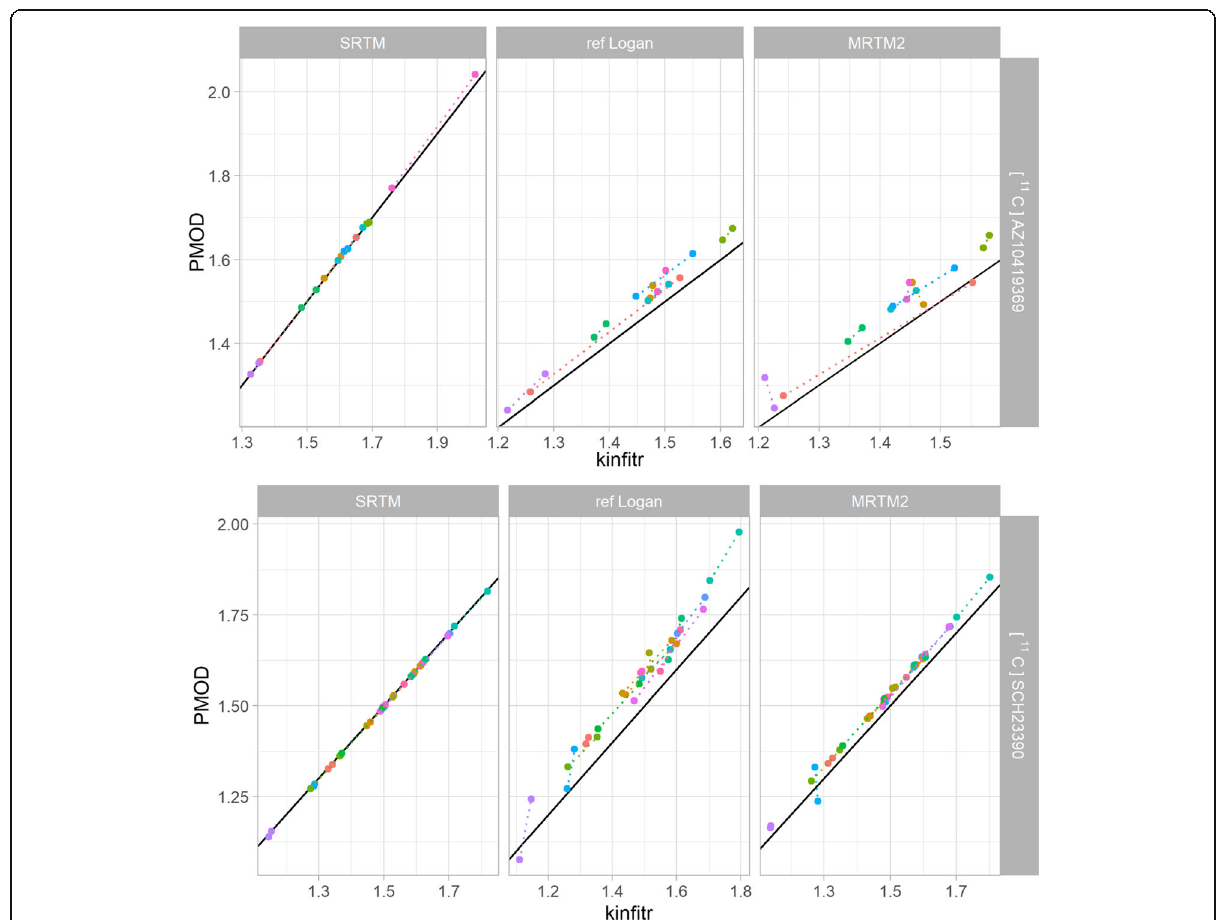
Fig. 1 Comparison of BP ND values calculated by kinfitr and PMOD. The relationship between binding estimates calculated by either kinfitr or PMOD. The results for the radioligand [ 11 C]AZ10419369 are derived from the occipital cortex ROI, and for [ 11 C]SCH23390, the striatum ROI. The diagonal line represents the line of identity. Each colour corresponds to a different subject, and the dotted lines connect both measurements from the same